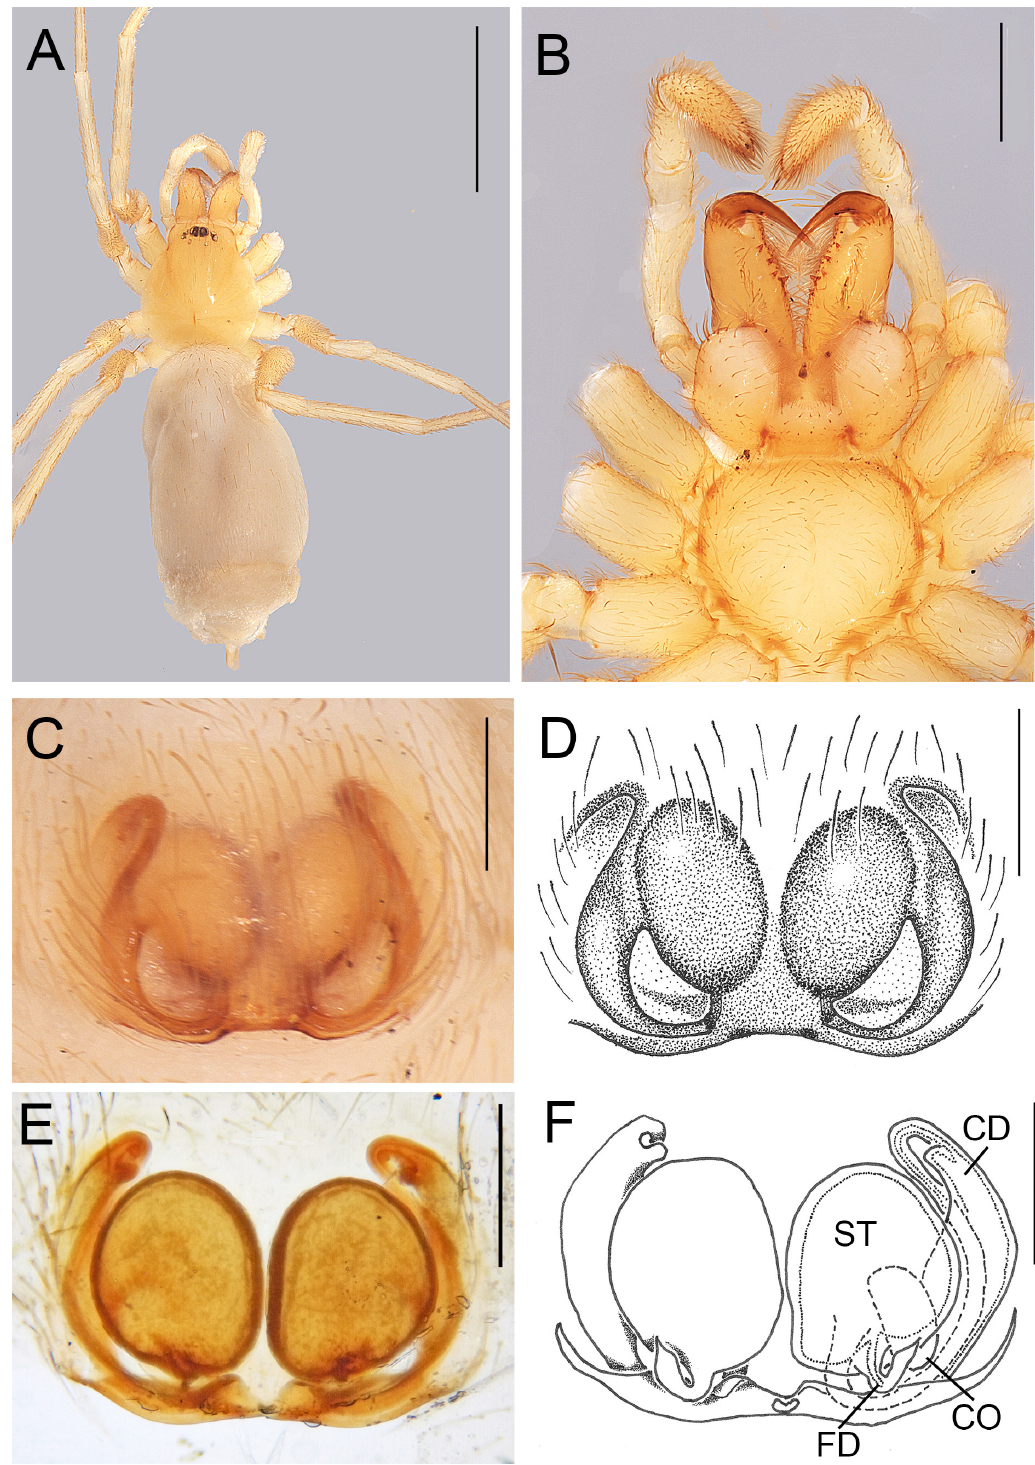
Fig. 25. Andromma ghesquierei sp. nov., ♀, paratypes. A–B . BE_RMCA_ARA.Ara 84109. C, E . BE_RMCA_ARA.Ara 177091. D, F . BE_RMCA_ARA.Ara 22878. A . Habitus, dorsal view. B . Cephalothorax, ventral view. C–D . Epigyne, ventral view. E–F . Same cleared, dorsal view. Abbreviations: CD = copulatory duct; CO = copulatory opening; FD = fertilisation duct; ST = spermatheca. Scale bars: A–B = 1 mm; C–E = 0.2